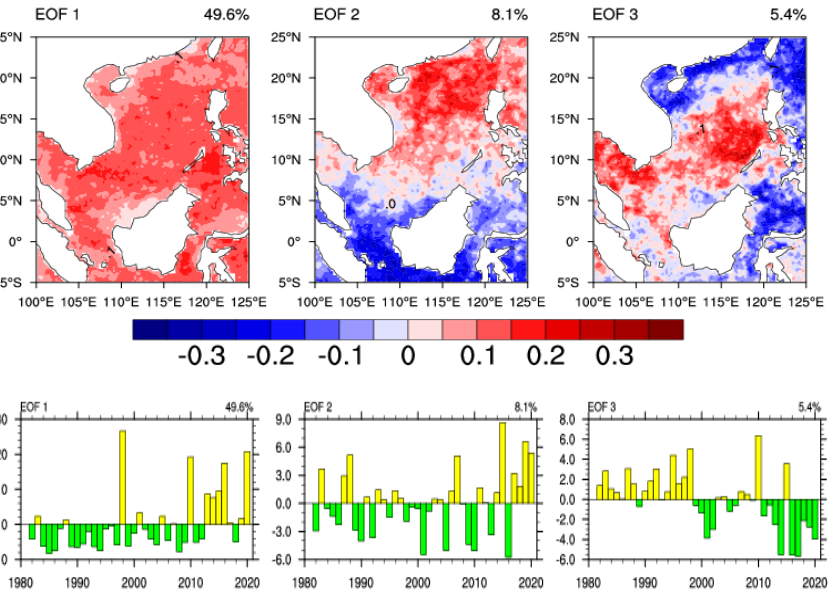
Figure 3. Spatial patterns of the three leading EOF modes ( top panels ) and the corresponding princi- pal components (PCs) time series ( bottom panels ) of MHWs frequency in warm season from 1982 to 2020. The figure’s upper right corner shows the percentage of variance explained by each mode.